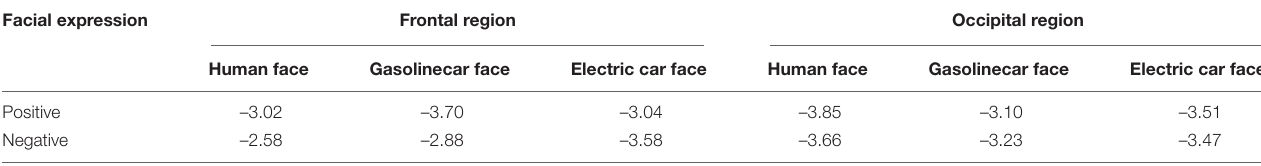
TABLE 1 | Descriptive data of N100 amplitudes for human and car faces (unit: µ